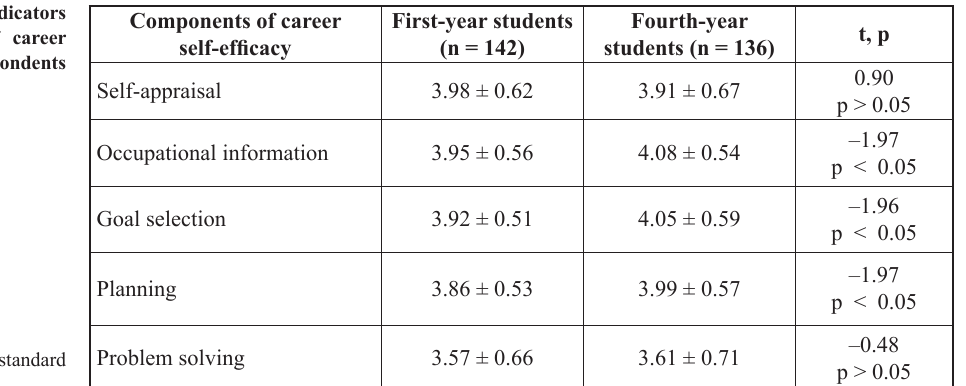
Note. M = mean; SD = standard